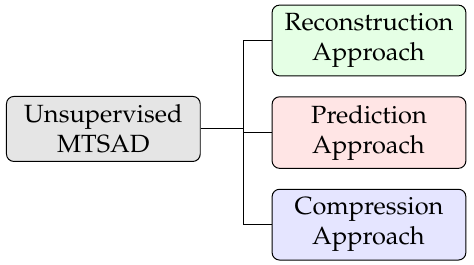
Figure 2. Approaches to unsupervised